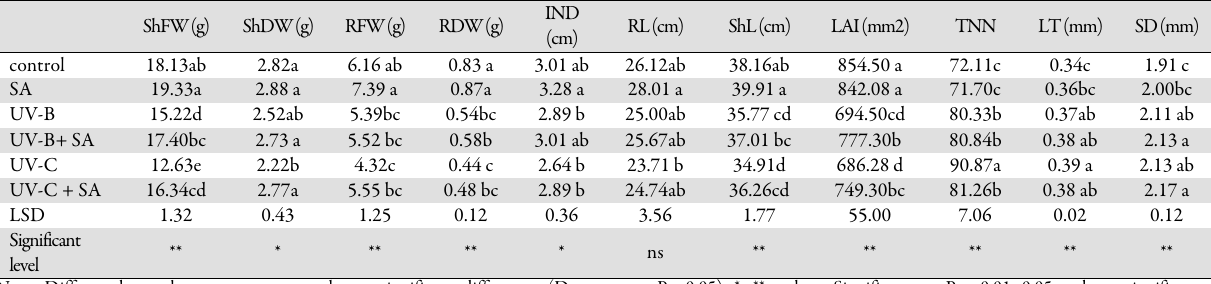
Table 1. Effect of different treatments on morphological factors at the flowering stage of Satureja hortensis L. ShFW